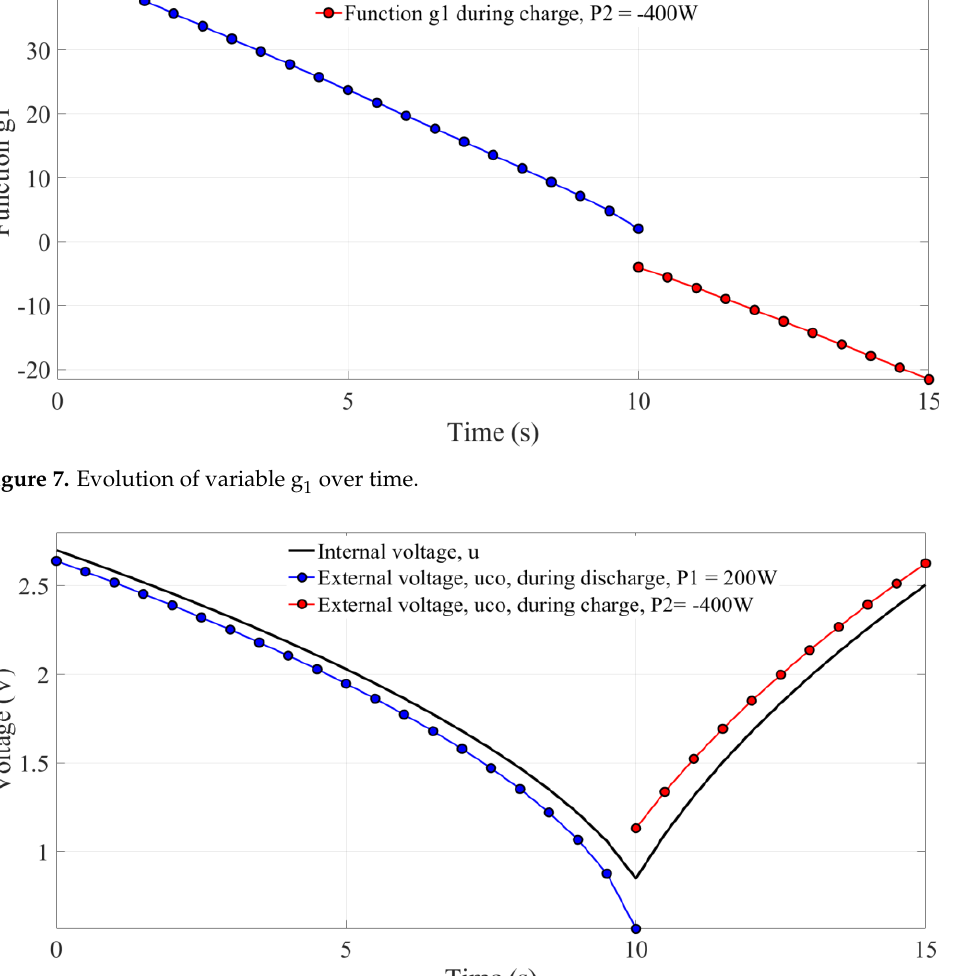
Figure 8. Evolution of the cell internal and external voltages over time.